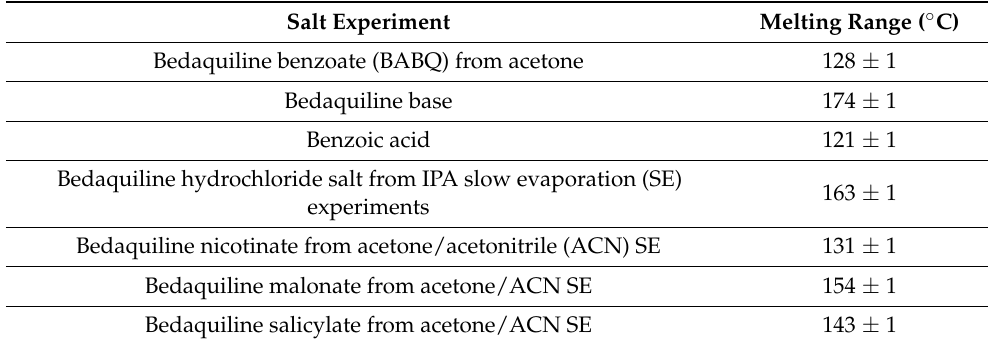
Table 4. Melting ranges obtained for different salts from study experiments.